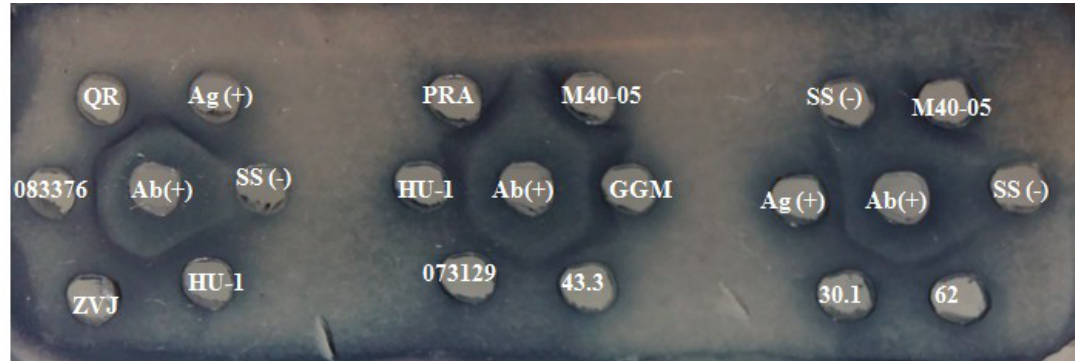
Figure 1. Immunological identification of coccidioidins. The identification of coccidioidins, based on the appearance of identity bands compared to the reference antigen through ID, was carried out according to the Methods section. Ag (+): Reference antigen; Ab (+): anti- Coccidioides -positive serum; SS (-): Saline solution.